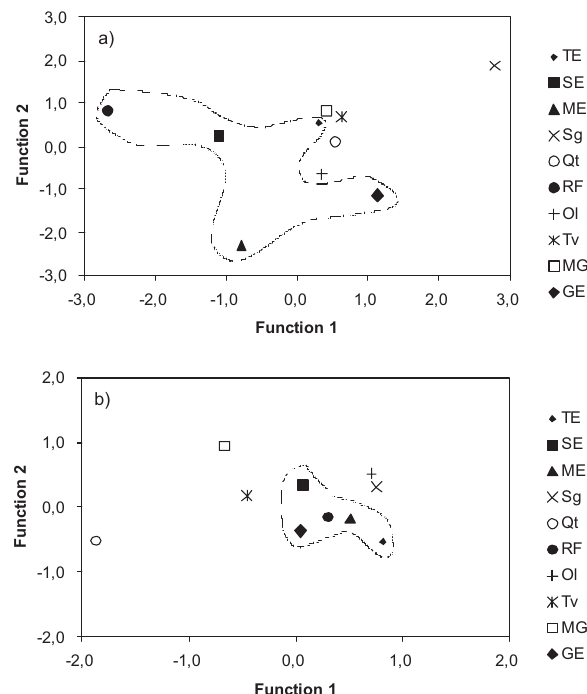
F IG . 2. – Plots of the centroids obtained from morphometric (a) and meristic (b) data analysis of H. didactylus samples, according to the first two discriminant functions. Estuarine samples are enclosed in the circle. TE, Tejo estuary; SE, Sado estuary; ME, Mira estuary; Sg, Sagres; Qt, Quarteira; RF, Ria Formosa estuary; Ol, Olhão; Tv, Tavira; MG, Monte Gordo; GE, Guadiana estuary.